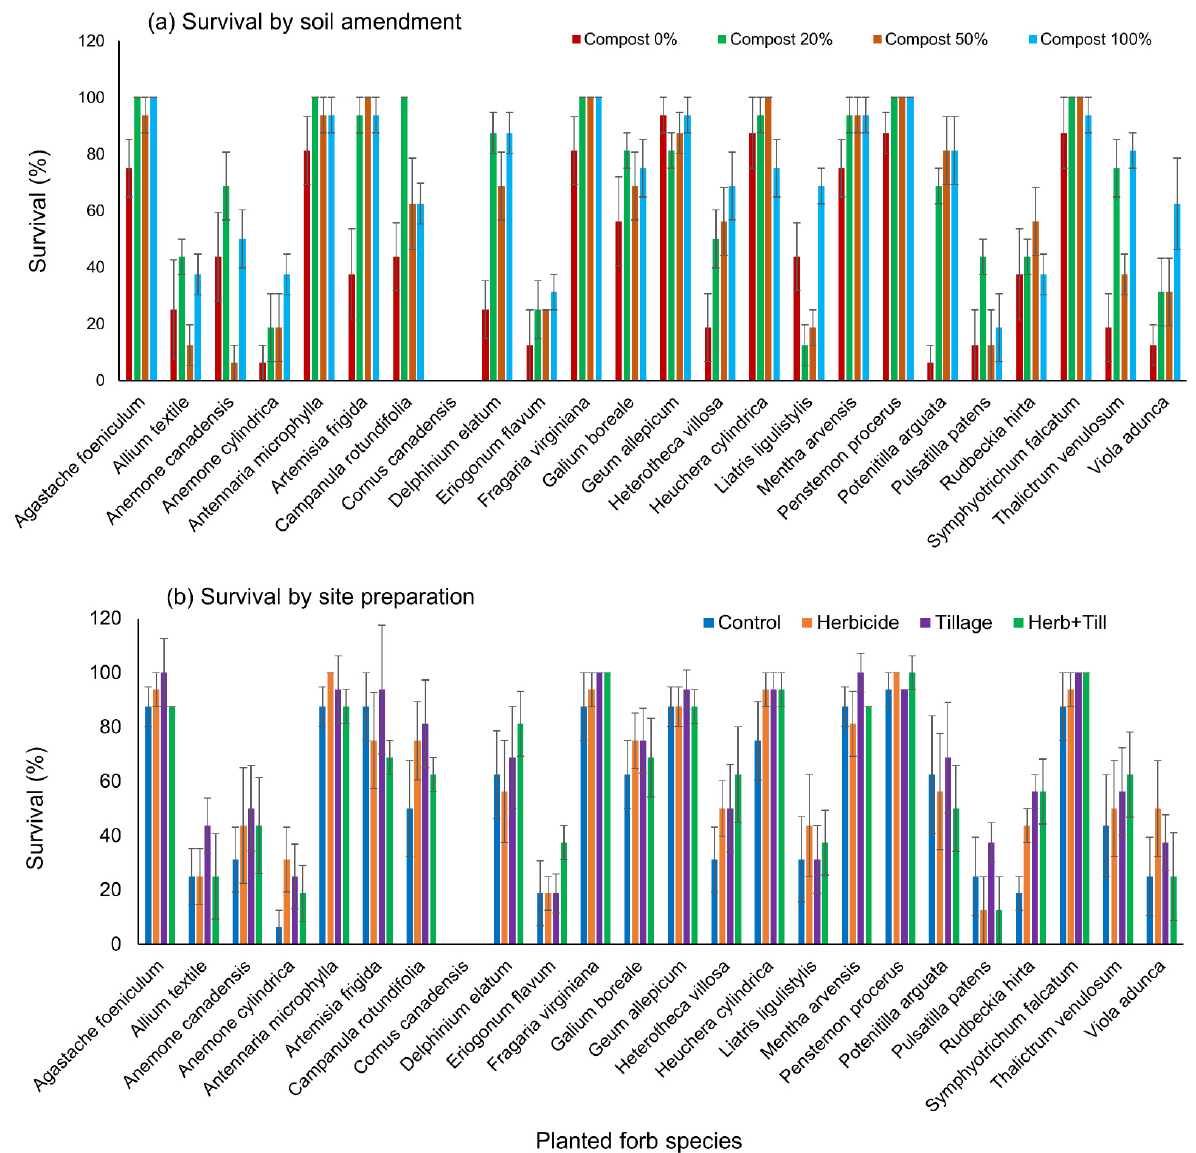
Figure 1. Mean (±SE) survival percent of planted forb by species at the end of monitoring dates in relation to ( a ) soil amendment and ( b ) site preparation. Herb + Till = Herbicide with tillage. When species were analyzed grouped by family, a significant effect of soil amend ‐ ment treatment on survival was found for Asteraceae, Ranunculaceae out of 12 families (Figure 2). Forb survival was significantly the lowest in compost 0% (unamended) for Asteraceae and the greatest in compost 100% (Figure 2). For Ranunculaceae, survival was significantly lower in compost 0% and compost 20%. Site preparation and interactions with amendment treatments did not significantly affect family survival.